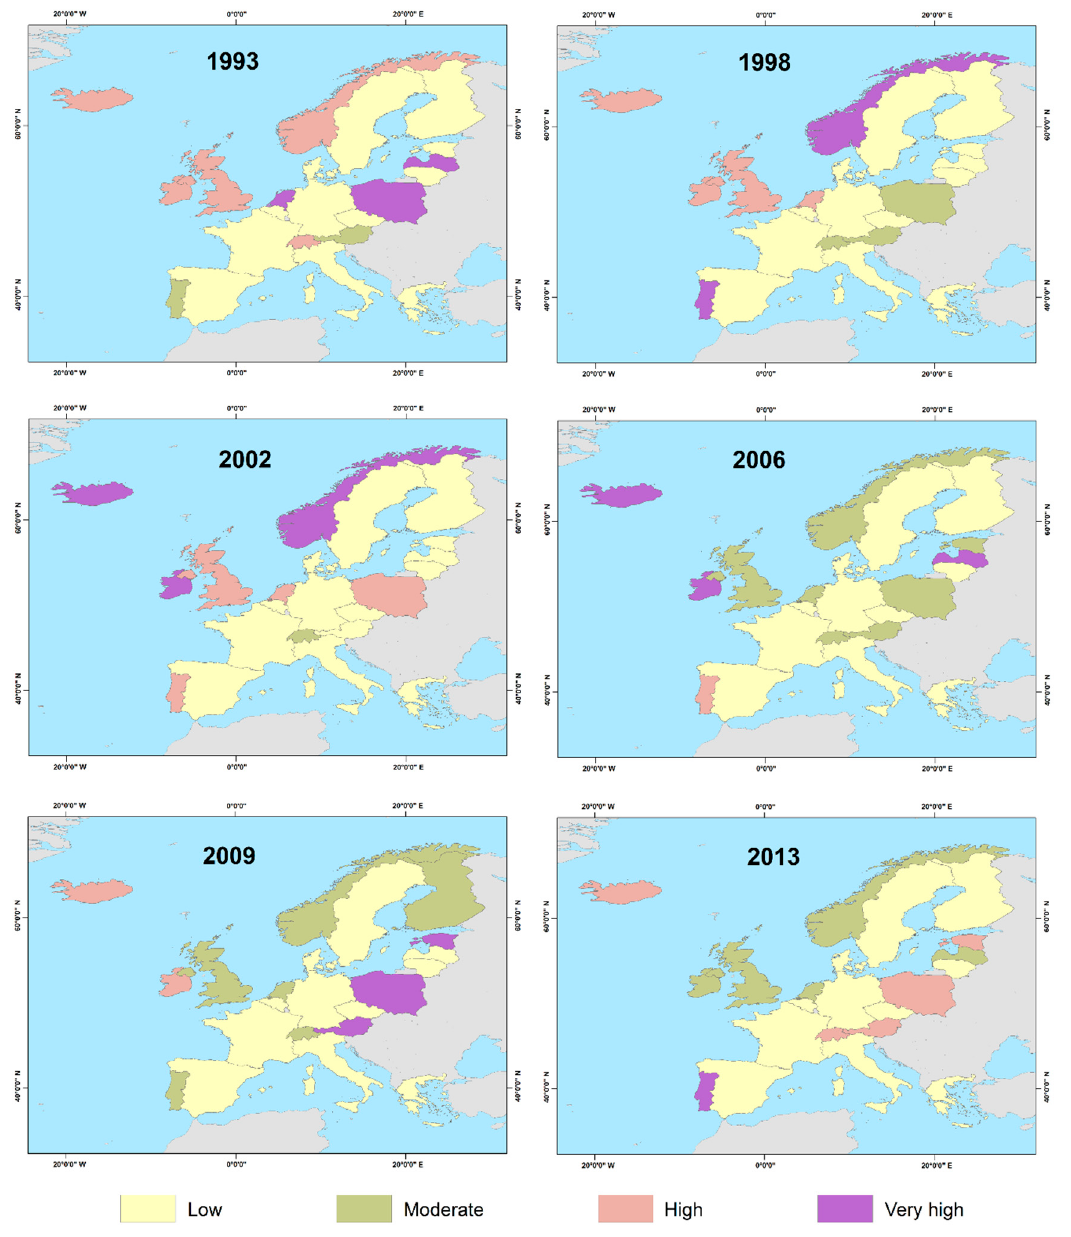
Figure 4. Infant mortality (parameter θ ) for male gender in 1993, 1998, 2002, 2006, 2009, and 2013.